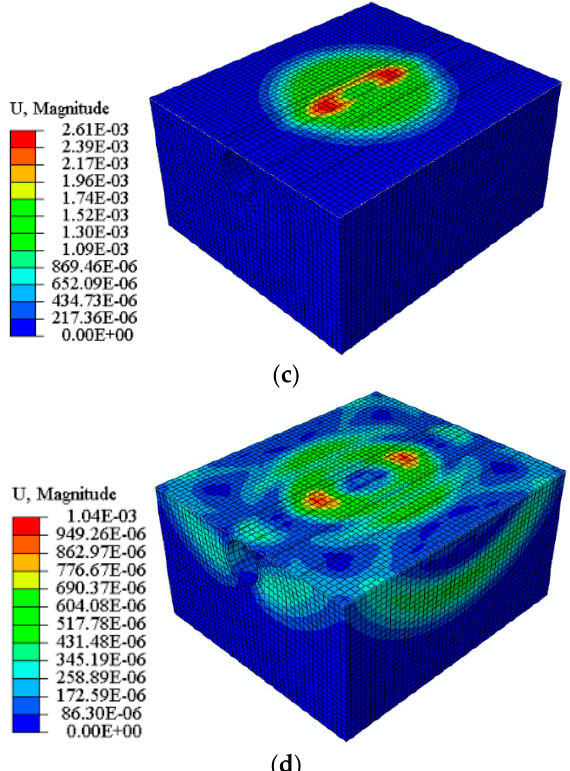
Figure 9. Deformation contours of ( a ) Jhingurda, ( b ) Singrauli, ( c ) Jamrani and ( d ) Kota when an impact loading occurs due to 100 kg missile.